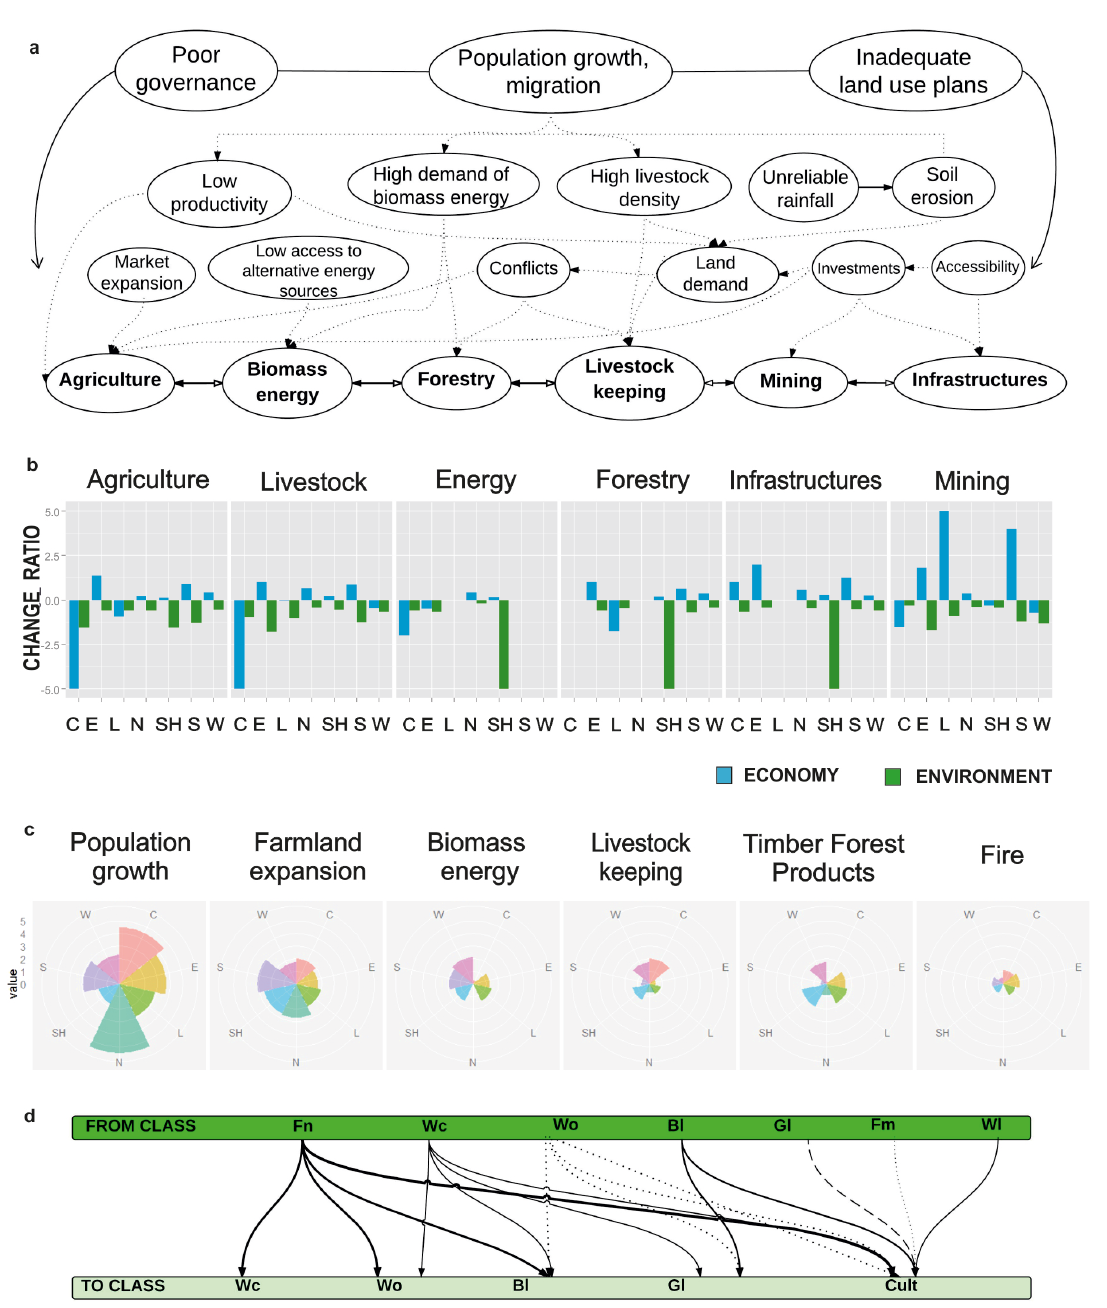
Fig. 5 . Synthesis of the qualitative and quantitative outputs from multistakeholder workshops, for the business as usual (BAU) scenario. Socioeconomic-environmental factors drive sectoral trajectories across units (a), determining different rates of changes between BAU scenario and current situation (b). Direct drivers related to socioeconomic trajectories (c) affect land use and land cover changes (d). In (a), top-down positioning symbolizes decreasing recurrence of factors in sectoral trajectories descriptions across zones. In (b), forestry and energy sectors were analyzed together in Central (C), Lake (L), Southern (S), and Western (W) Zones, and separately in Eastern (E), Northern (N), and Southern Highlands (SH) Zones. In (d), Fn = natural forest; Fm = mangrove forest; Wc = closed woodland; Wo = open woodland; Bl = bushland; Gl = grassland; Th = thicket; Cult = Cultivated land; Fp = Forest